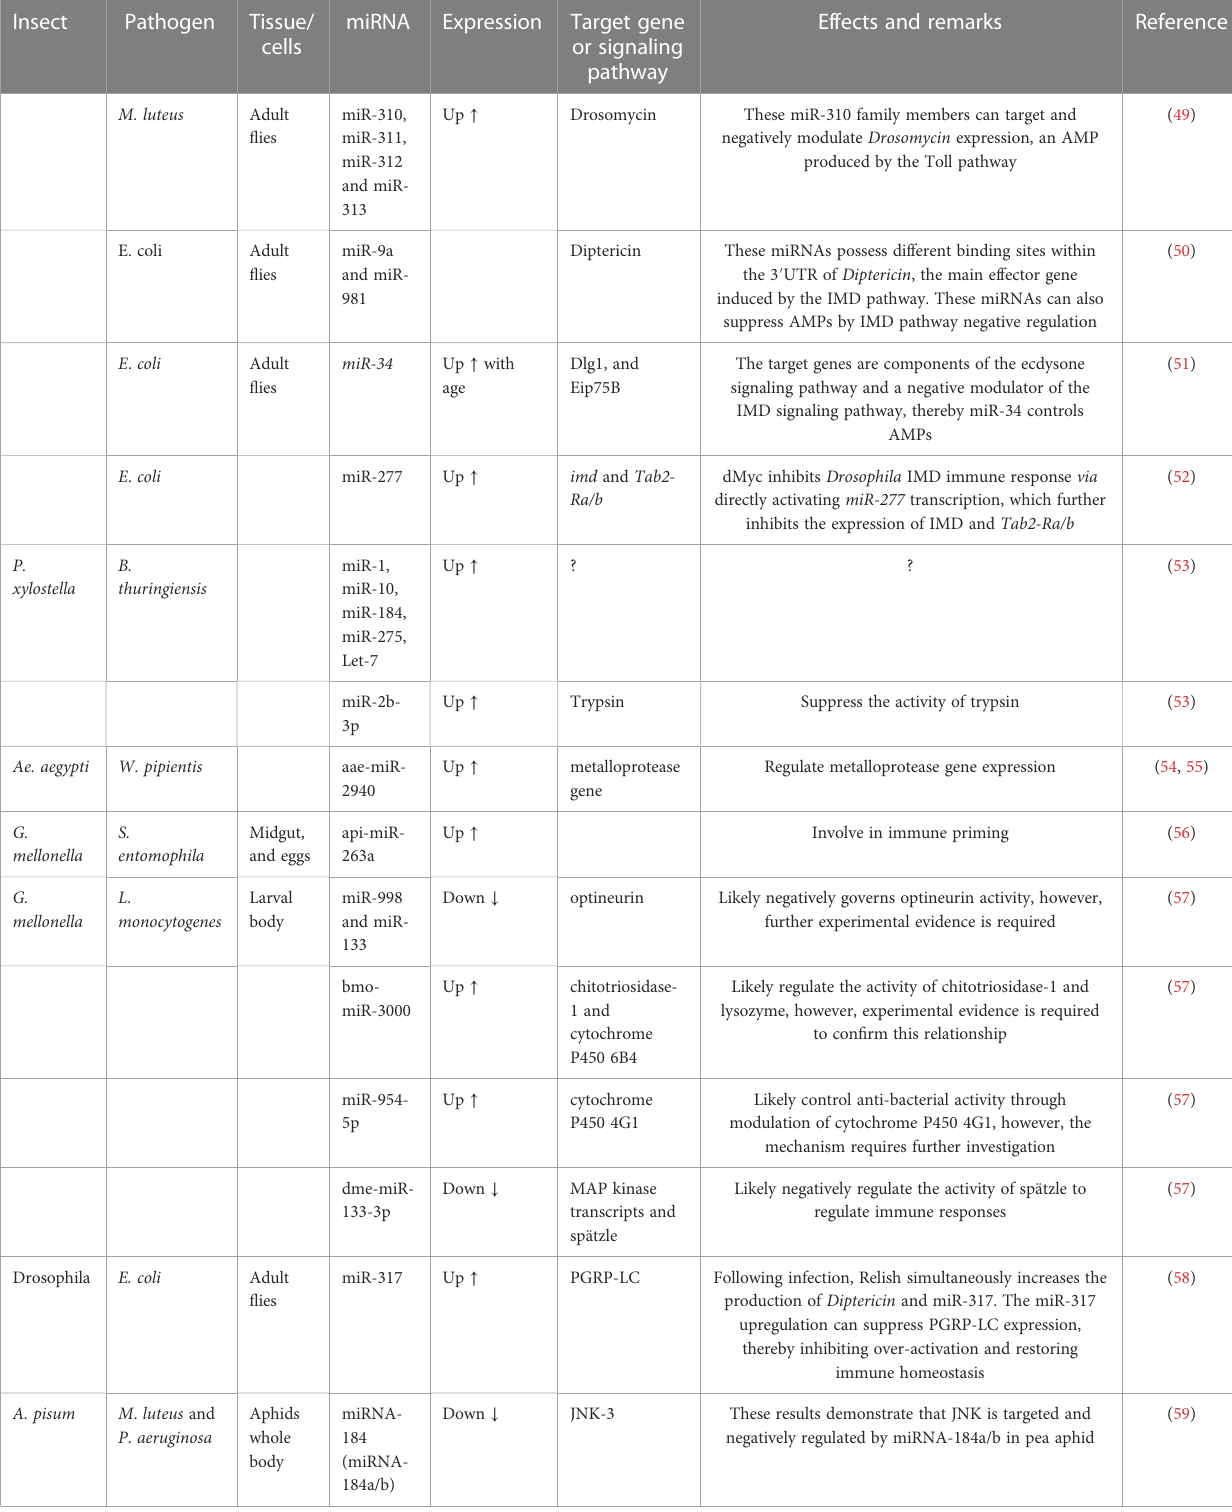
↑ upward arrow indicates that the expression of miRNA induced. ↓ Downward arrow shows that the expression of miRNA reduced. ? question mark shows that relevant information is still